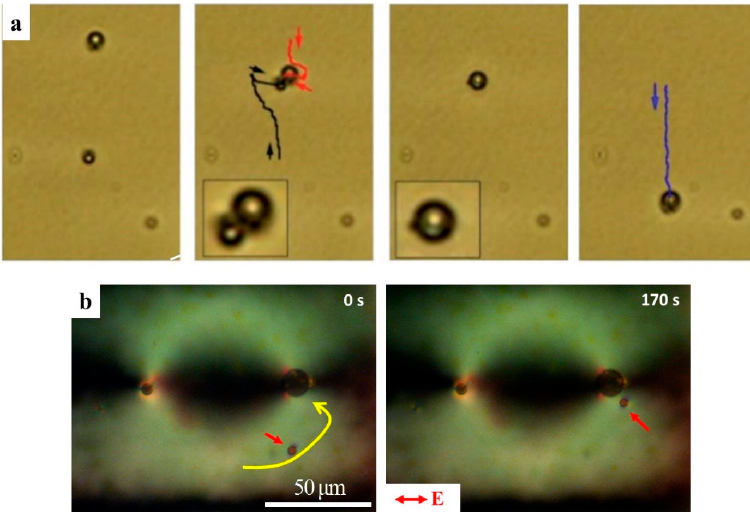
Figure 12. Liquid crystal-enabled electrokinetics (LCEK) applications in controlled microreactions. ( a ) Two water droplets stabilized by surfactants that impose perpendicular anchoring and loaded with specific reactants, are driven by LCEP in a uniformly aligned nematic chamber towards each other, until they coalesce and start a chemical microreaction [37]; ( b ) LCEO flows in a prepatterned nematic cell of the type shown in Figure 10a, with a ( − ½, ½) disclination pair, carry a surfactant-free water droplet (marked by a small arrow) towards a core of the ½ disclination where it coalesces with another droplet already trapped at the defect (the trajectory is shown by a curved arrow) [26]. Adapted with permission from